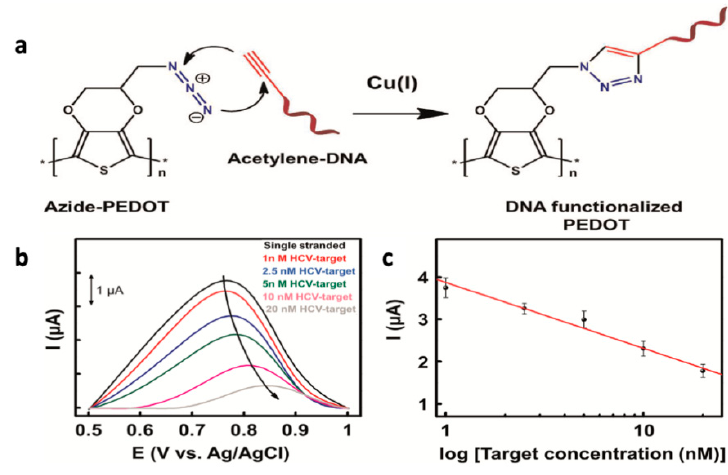
Figure 19. ( a ) DNA immobilization onto azido-PEDOT-modified gold electrodes via click chemistry. ( b ) Amperometric sensor response to increasing concentrations of target DNA, and ( c ) the